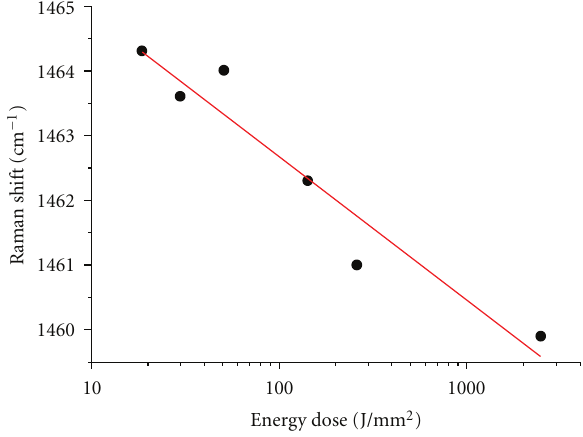
Figure 7: Relationship between the Raman shift of A g (2) peak and the energy dose of C 60 NWs irradiated by the excitation laser